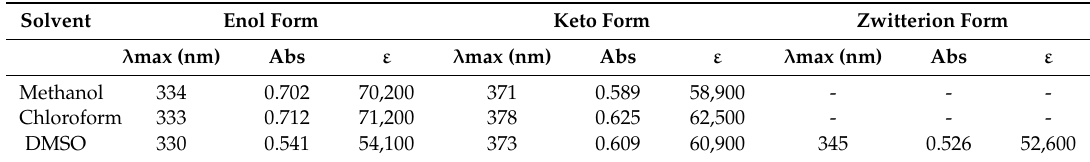
Table 6. UV absorption bands, molar extinction coe ffi cient (L.mol − 1 .cm − 1 ), and solvent e ff ects on the tautomerism of Compound 3 in di ff erent solvents at room